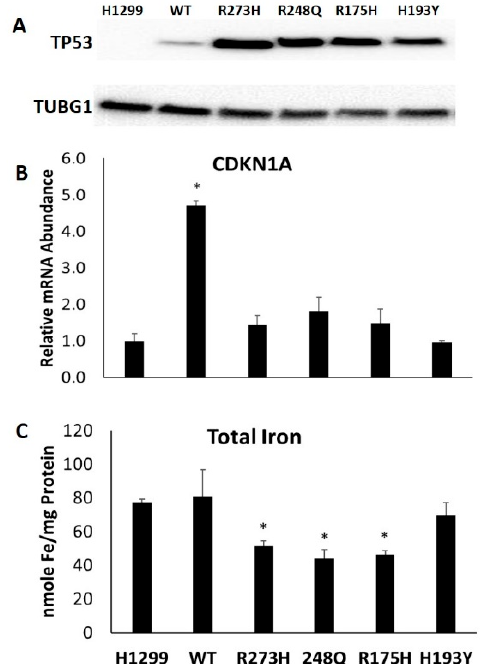
Figure 1. Influence of TP53 induction on total intracellular iron levels. TP53 null H1299 cells (H1299) were transfected with either a tetracycline inducible wild-type (WT) TP53 or a representative contact (R237H or R248Q) or conformational (R175H or H193Y) mutant TP53. ( A ) Western blot of TP53 expression levels in each following tetracycline induction. ( B ) Relative CDKNA1A mRNA expression levels following tetracycline induction of WT TP53 and indicated TP53 mutants. ( C ) Total intracellular iron was differentially altered in response to the induction of distinct TP53 mutation types. * Denotes statistical difference from H1299, p < 0.05.